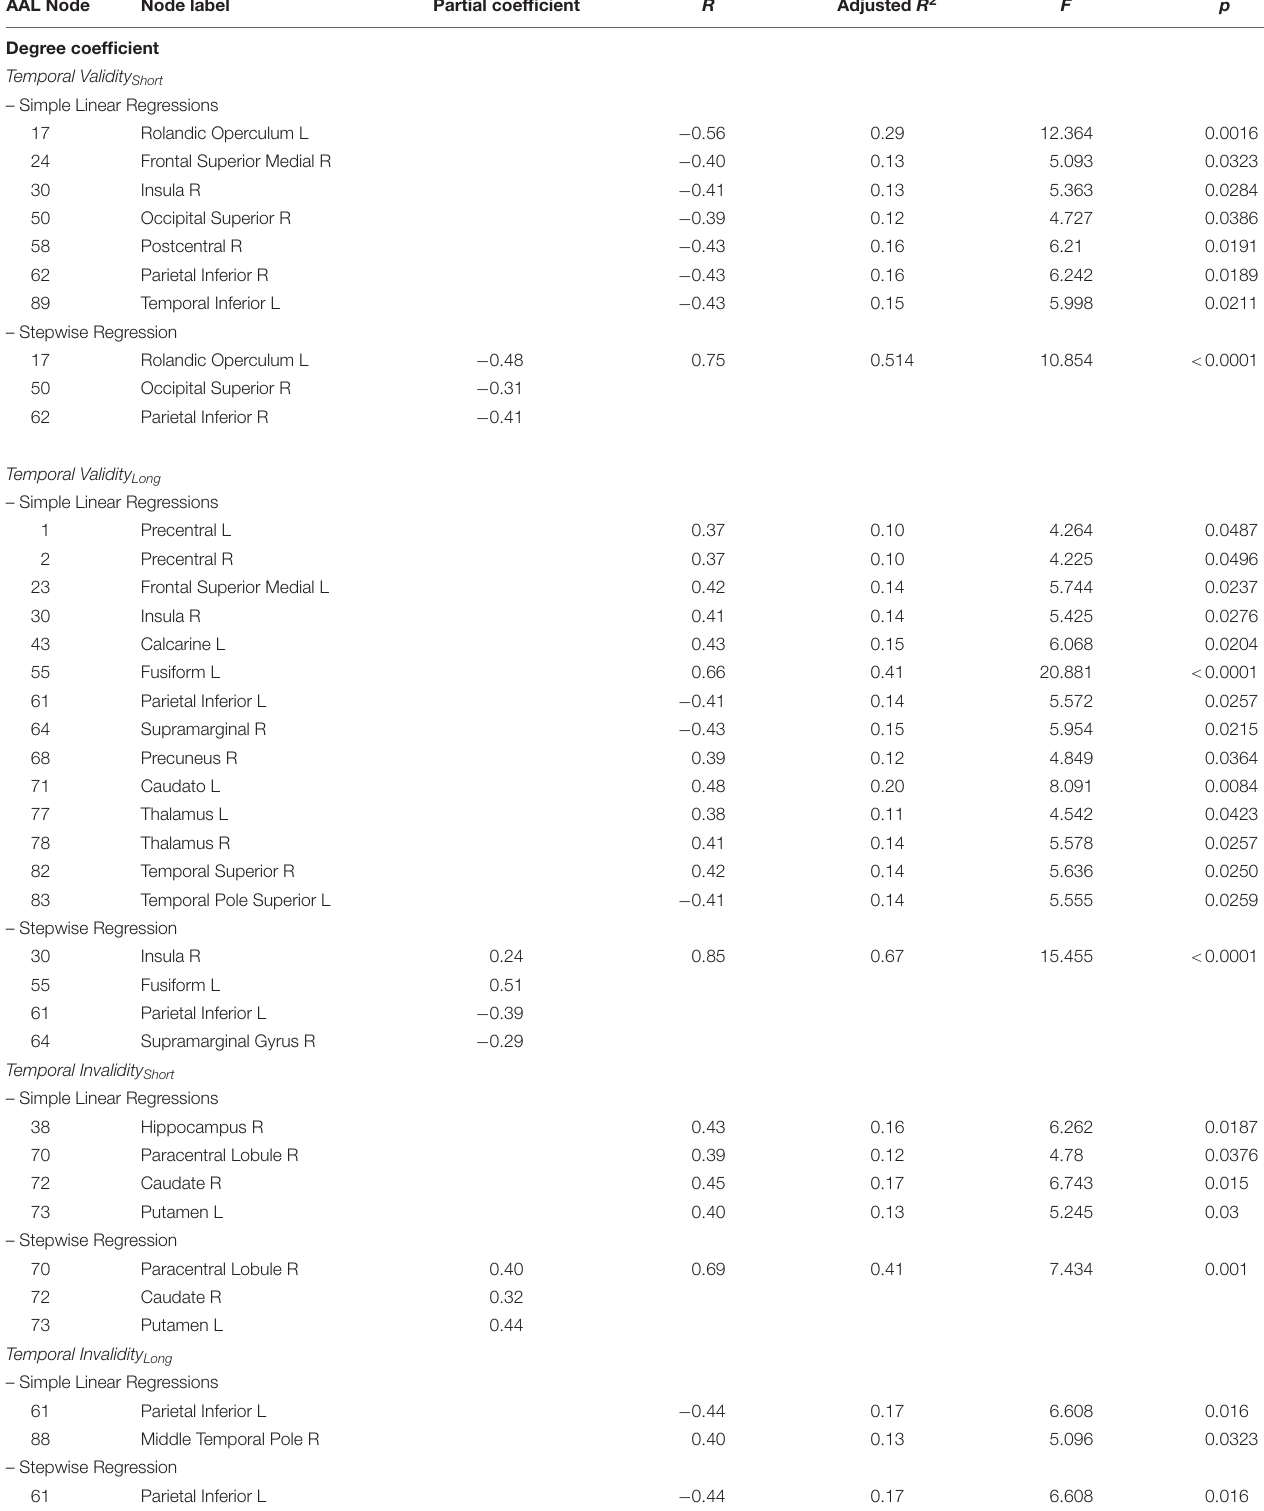
TABLE 2 | Observed covariance between degree centrality and spatio-temporal predictive performance. AAL Node Node